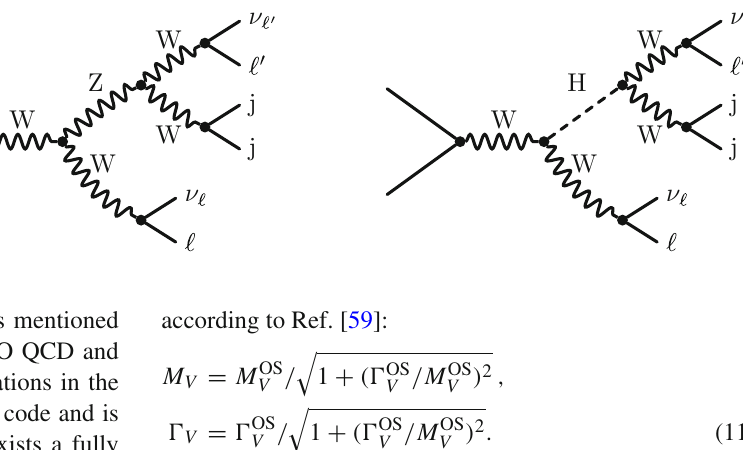
Fig. 1 Graphical representation of the two diagrams with the highest number of massive resonances for ν (cid:3) (cid:3) ± ν (cid:3) pp → (cid:3) ± jj. 1 2 1 2